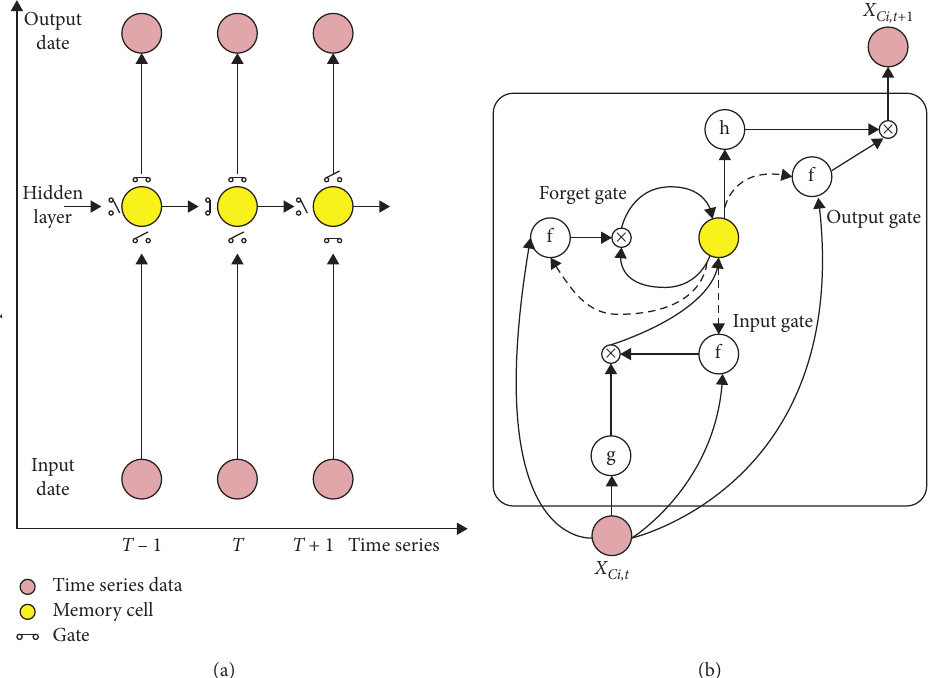
Figure 2: LSTM network structure with a single LSTM memory cell. (a) LSTM network structure. (b) A single LSTM memory